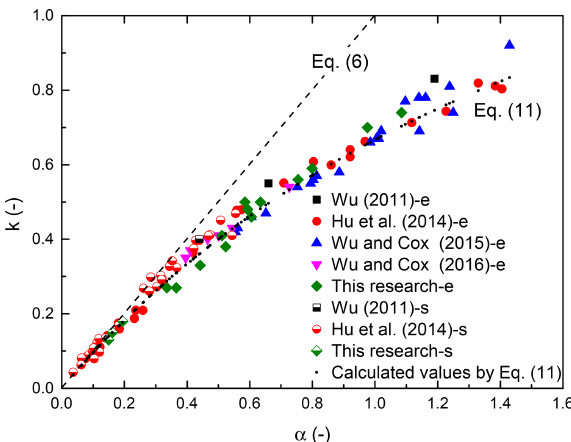
Figure 3. Comparison of calibrated α and k . Different symbols indi- cate cases from different research studies and emergent conditions. For emerged and submerged cases, “-e” and “-s” are added after the references as the legend shows. The dashed and dotted lines indicate calculation by Eqs. (6) and (11), respectively.